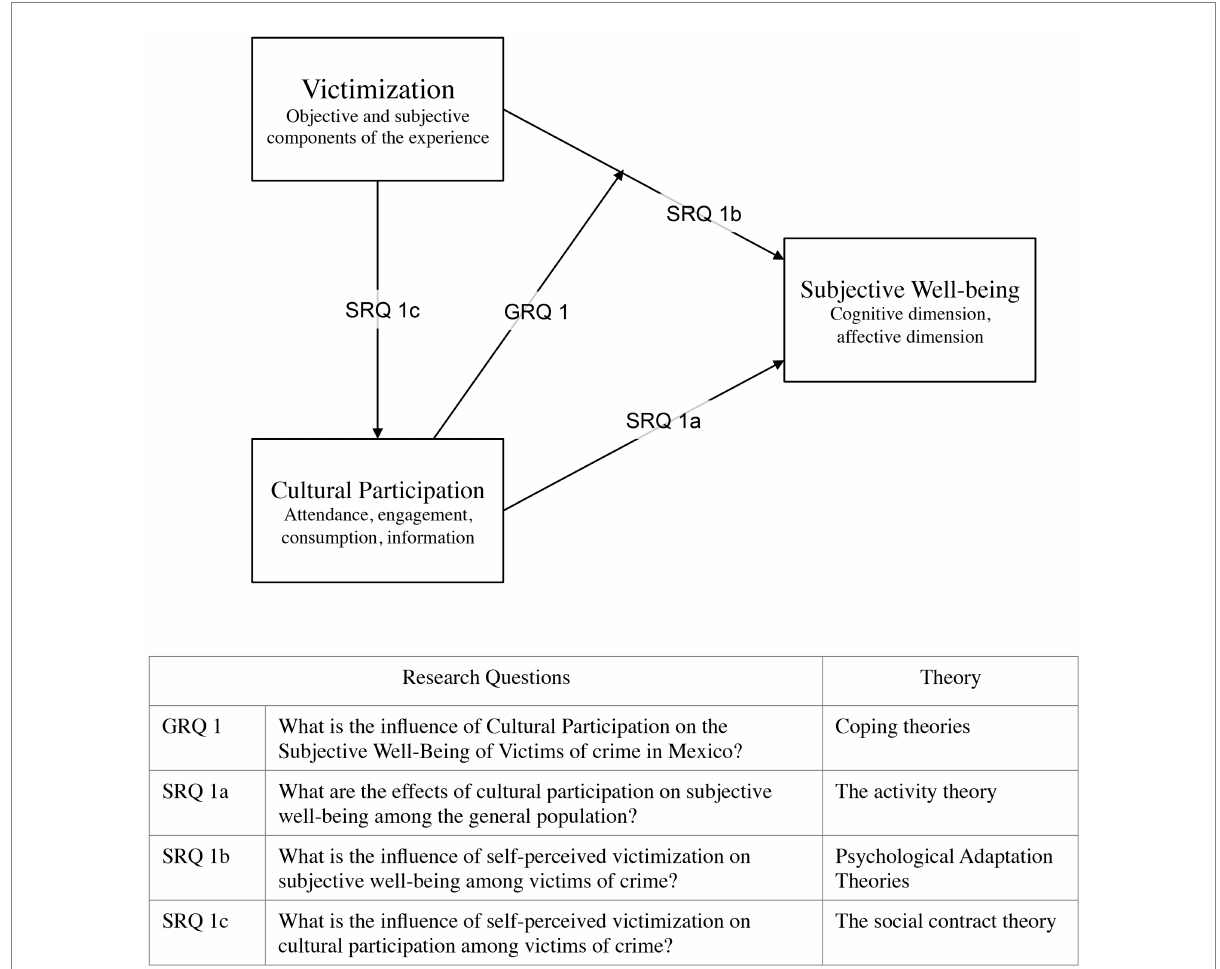
FIGURE 1 Conceptual model. GRQ1, General Research Question; SRQ1a, Specific Research Question 1a; SRQ1b, Specific Research Question 1b; SRQ1c, Specific Research Question 1c. Proposed theoretical model between victimization, cultural participation, and subjective well-being. Each arrow corresponds with one of the research questions and the theories exposed in the previous